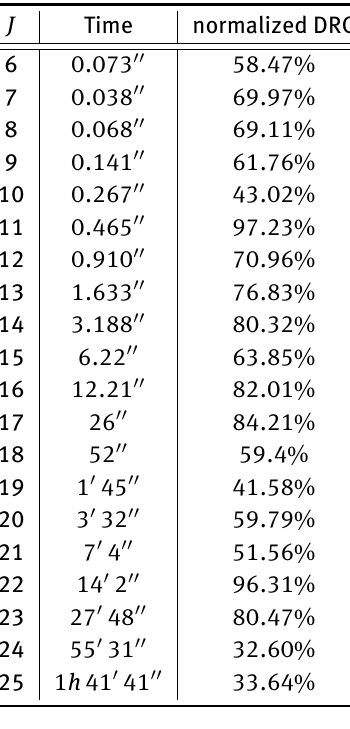
Table 1: Table representing the computation time and the normalized 99.9% DRC equal to DRC / (cid:80) J denoted as y , for portfolios simulated with different dimensions J .